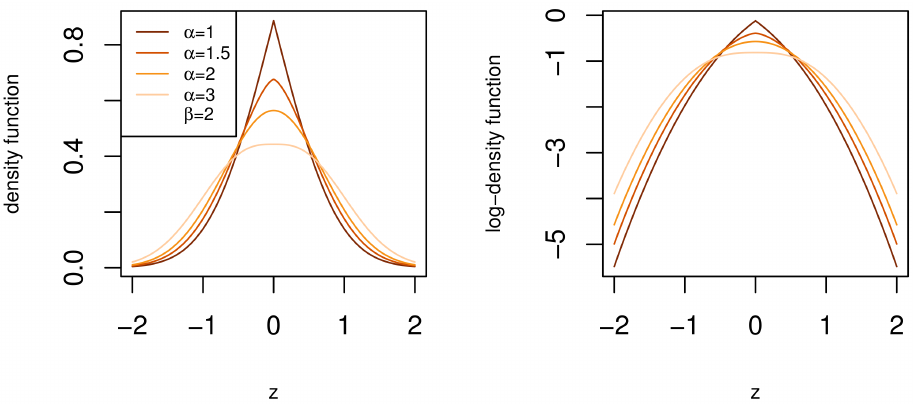
Figure 4. The density function of the BTGN distribution for different body shapes α for a fixed tail shape of β = 2.